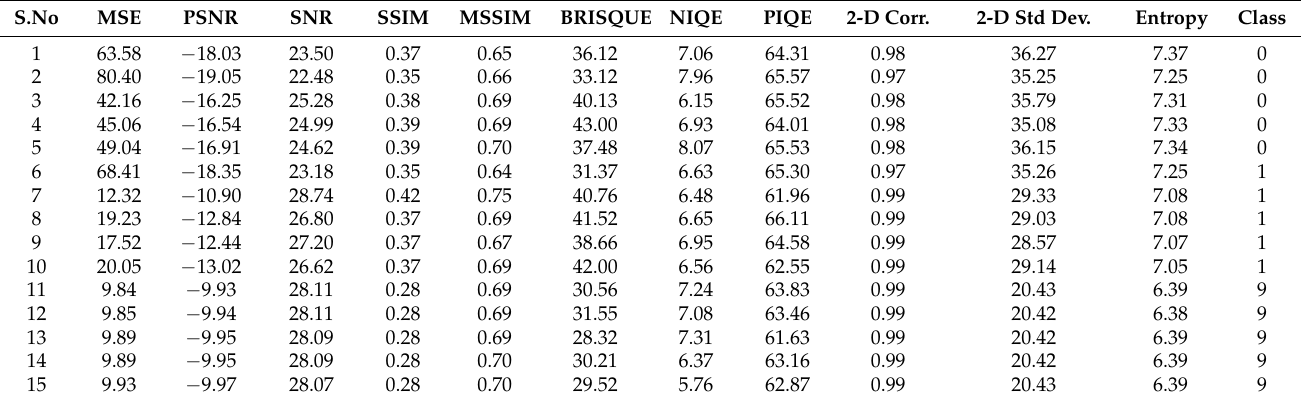
Table 2. Sample IQP feature vector.